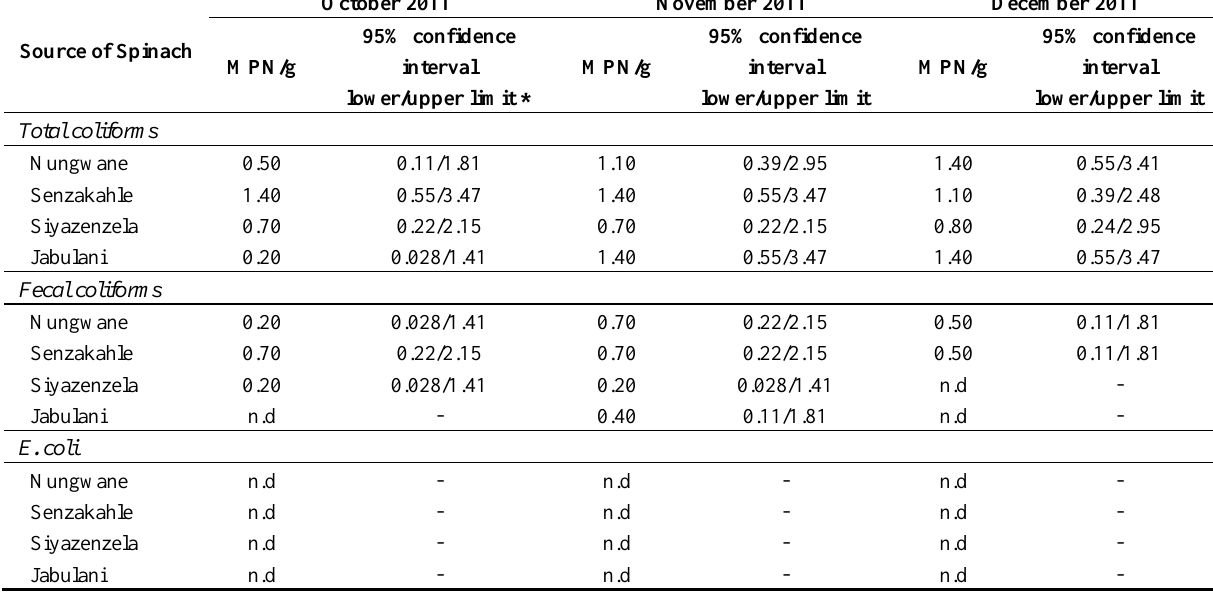
Table 6. MPN per g of spinach for total and fecal coliforms as well as E. coli produced by different farmer cooperatives for the months of October, November, and December 2011. Source of